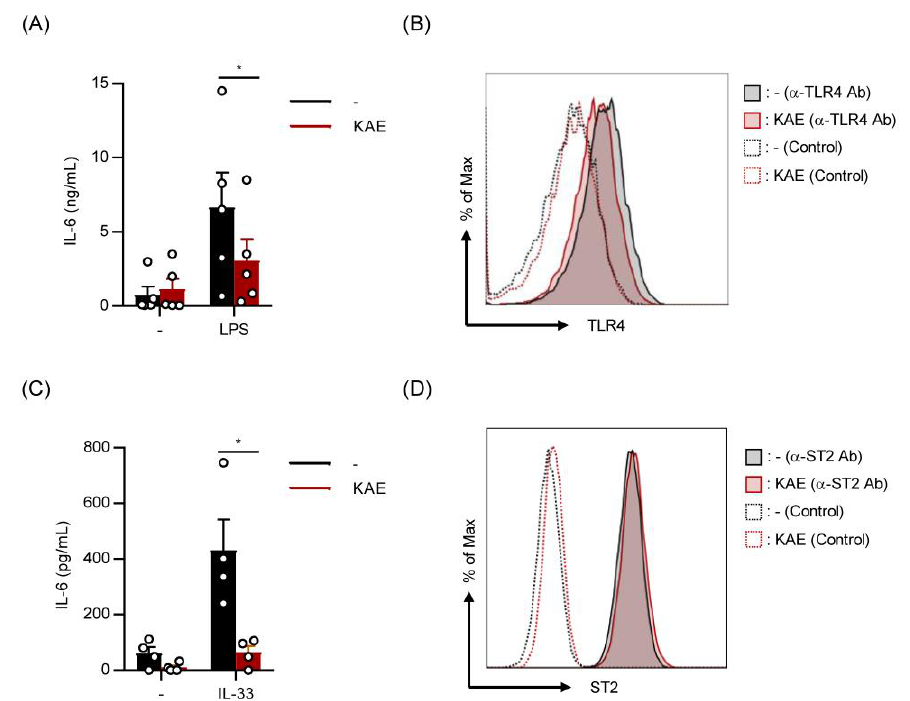
Figure 3. Kaempferol suppressed LPS- and IL-33-induced IL-6 production without affecting cell surface levels of TLR4 and ST2 on BMMCs. BMMCs were pre-incubated in the presence or absence of KAE (50 µ M) for 24 h followed by each assay. ( A ) BMMCs were stimulated with LPS (1 µ g/mL) for 3 h and the supernatant was collected to determine the concentration of IL-6. ( B ) The cell surface expression levels of TLR4 after KAE treatment. Typical histogram obtained in two independent experiments is shown. ( C ) BMMCs were stimulated with IL-33 (10 ng/mL) for 3 h and the supernatant was collected to determine the concentration of IL-6. ( D ) The cell surface expression levels of ST2 after KAE treatment. Typical histogram obtained in two independent experiments is shown. The data represent the mean ± SEM of four or five independent experiments, and two-tailed paired t -tests were used for statistical analyses ( A , C ). *, p < 0.05. Abbreviation: KAE, Kaempferol; α -TLR4 Ab, anti-TLR4 antibody; α -ST2 Ab, anti-ST2